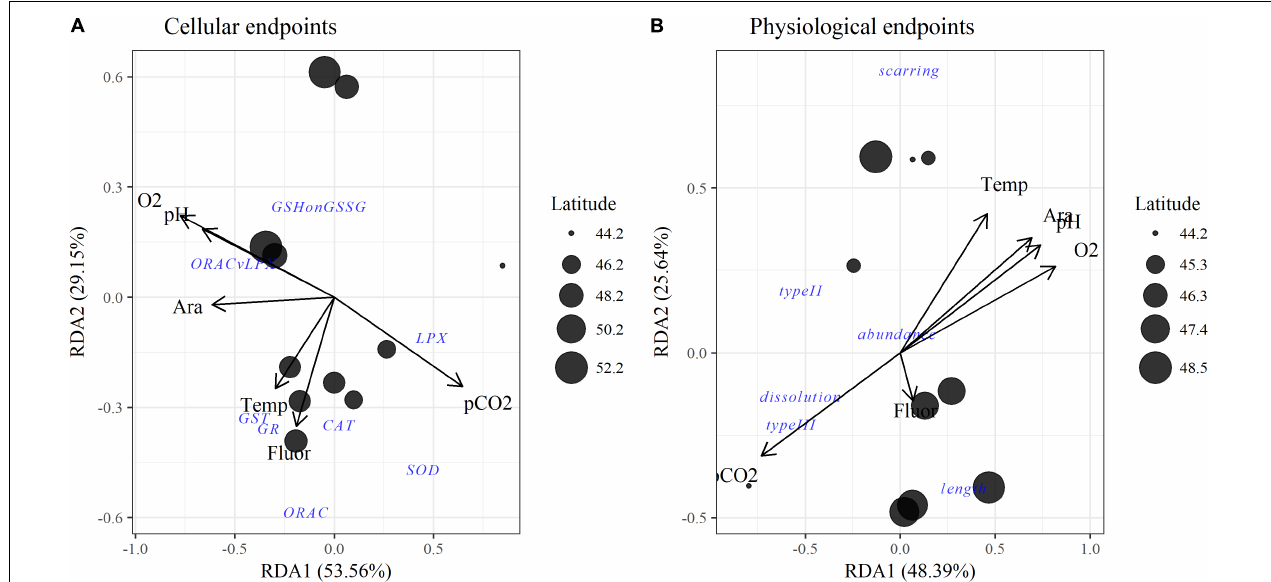
FIGURE 4 | Redundancy analyses (RDAs) for environmental variables with pteropod (A) cellular and (B) physiological and population endpoints. Points are site locations in multivariate space with the size proportional to latitude. Separate RDAs were created for cellular and physiological endpoints because not all data were available across all stations. Ara, aragonite saturation state ( (cid:127) ar ). For abbreviations of oxidative biomarkers refer to Table 1